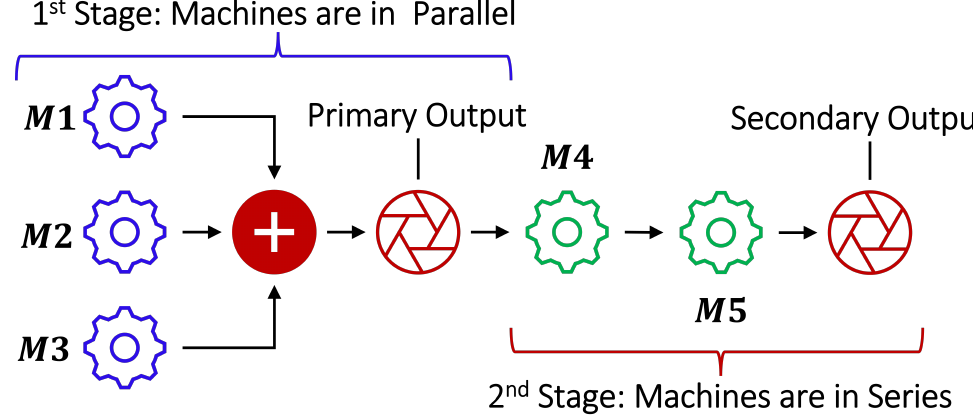
Figure 2. Architecture of the manufacturing process used as a case